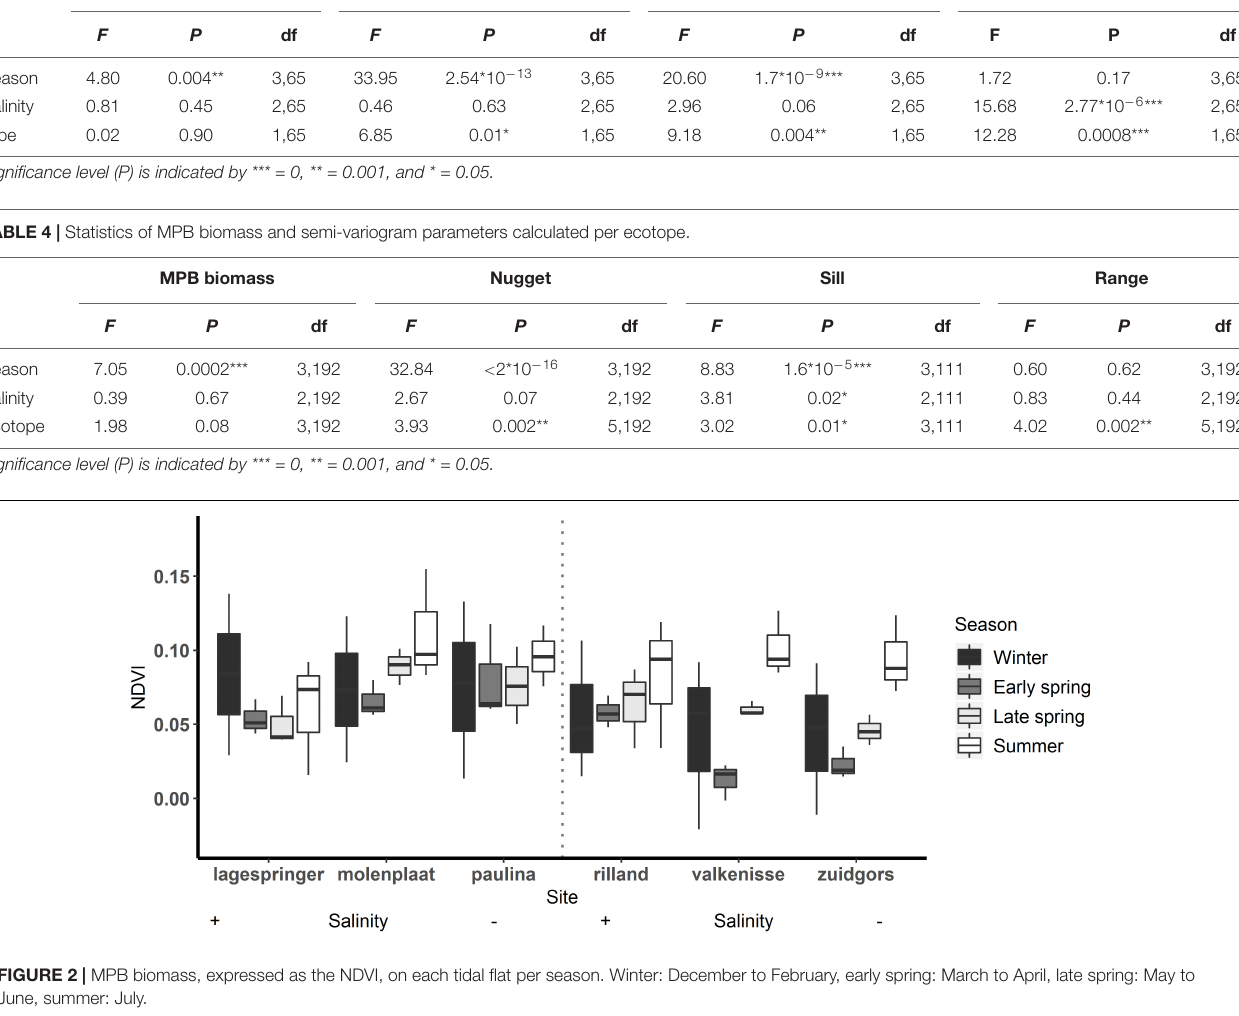
major range was estimated visually from anisotropy maps and was highly consistent throughout the year (Lage springer: ± 135, Molenplaat: ± 60, Paulinapolder: ± 115, Rilland: ± 70, Valkenisse: ± 100, Zuidgors: ±